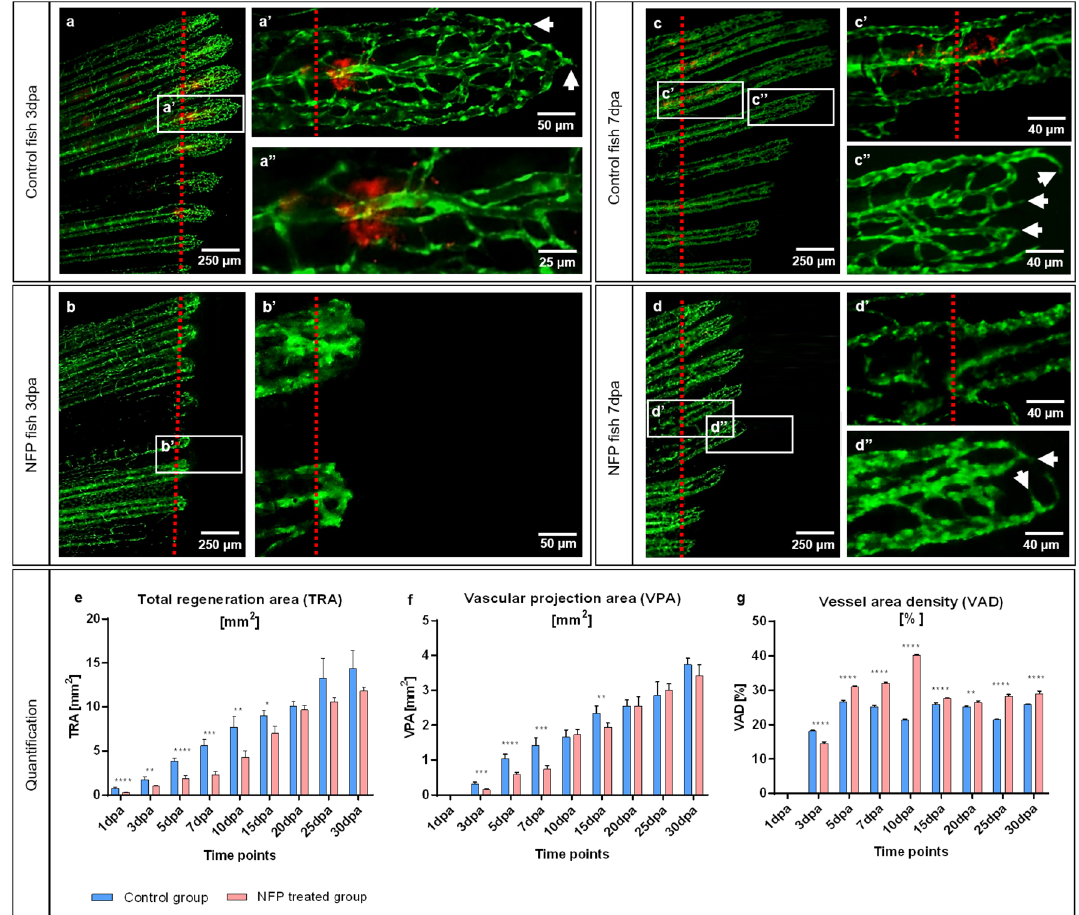
Figure 6. Ablation of collagen 1α2 producing cells by NFP impair caudal fin regeneration and vascular development. In the control animals, at 3dpa and 7dpa, classical tissue regeneration pattern and blood vessel morphology are documented ( a , c ). Multiple active cells producing collagen 1α2 (in red) are present adjacent to the amputation line ( a’ , a’’ , c’ ). Those cells are not detectible in NFP inhibited animals ( b , b’ , d , d’ ). Regenerative area and vascular plexus appear shorter and underdeveloped in the NFP-treated group at both, 3dpa and 7dpa. Arrows indicated sprouts. Green - ECs, red dotted line - amputation plane, images acquired by fluorescent reflected light microscope. a’’ part of a’ at higher magnification. Quantification of the regeneration and vascularization after the elimination of the collagen 1α2 producing cells has been performed by three variables: Total regenerated area (TRA = regenerated fin in mm 2 ; ( e ), vascular projection area (VPA = vessels growth within regenerated fin in mm 2 ; ( f ) and vessel area density (VAD = vessels density within the regenerated fin in %; g) during the period of 30 days in control group (blue) versus NFP-treated group (red). n =